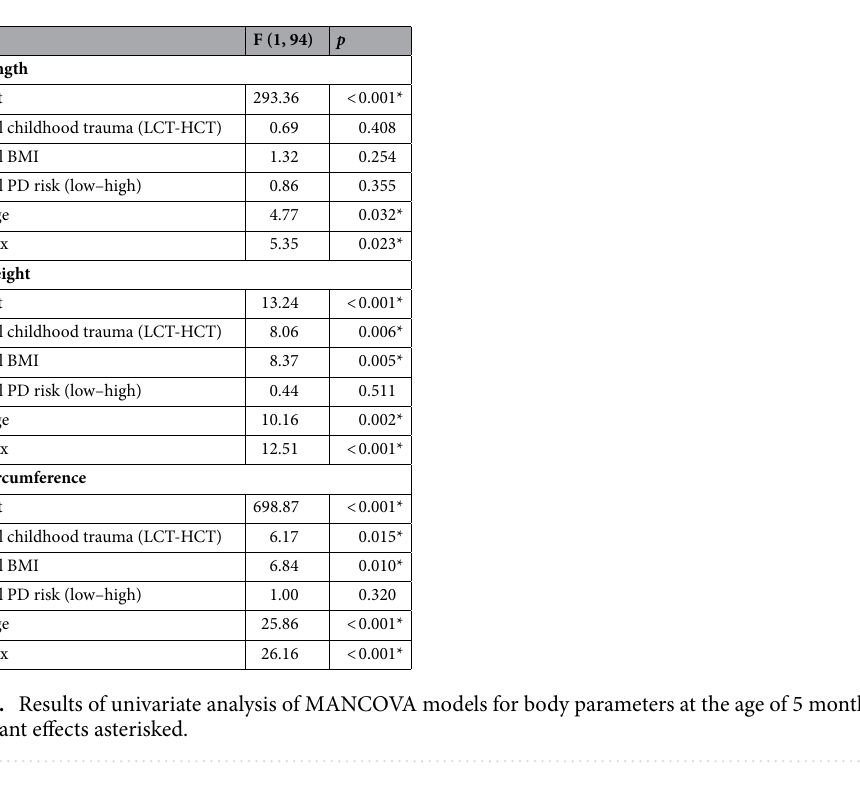
Model F (1, 94) p Body